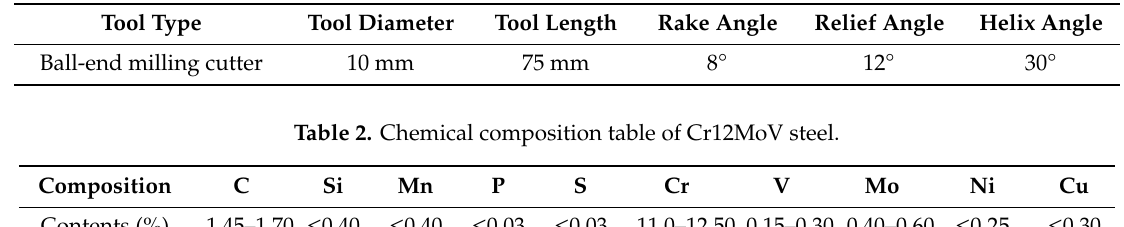
Figure 10. Simulation results of surface topography after removal of curvature. ( a ) Residual height z after removal of curvature; ( b ) three-dimensional image after removing curvature.